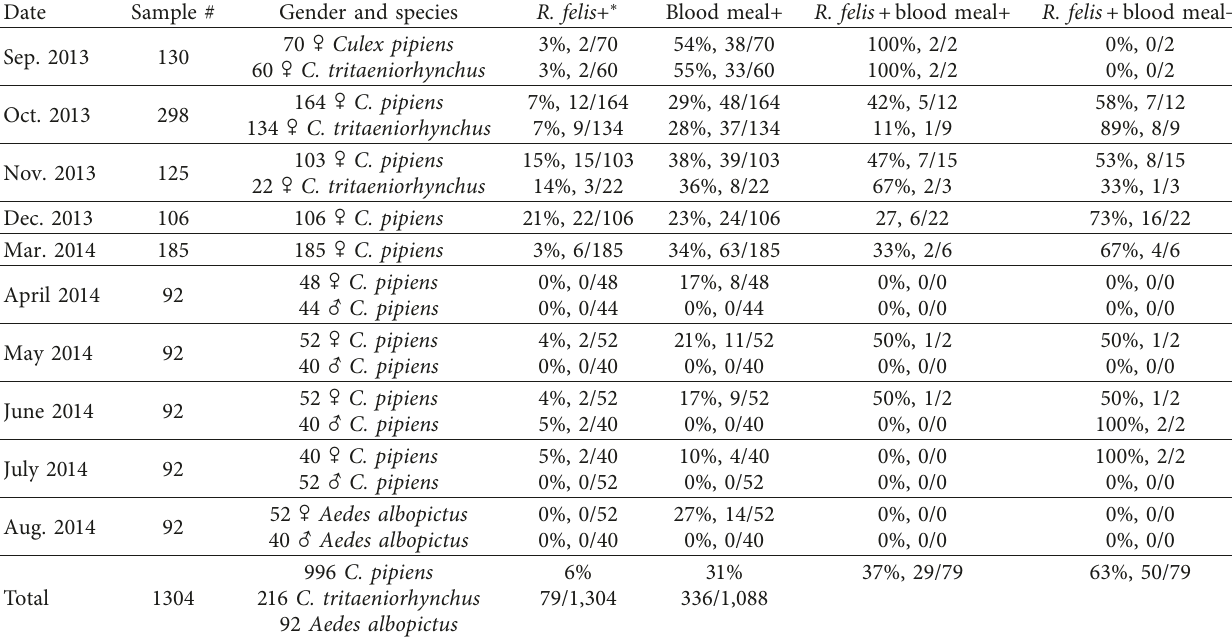
Table 2: Prevalence of R. felis and blood meal in mosquitoes in this